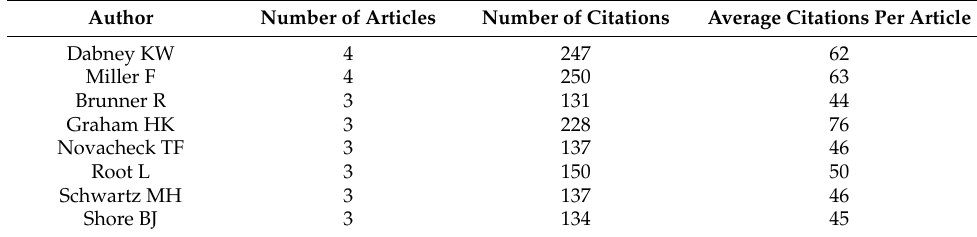
Table 4. Top 8 most productive